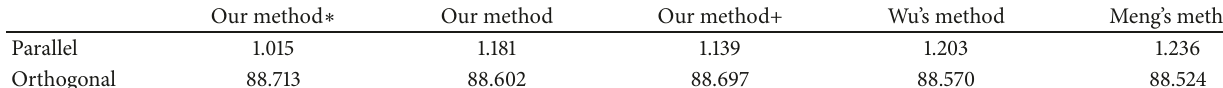
Table 2: The angle of 3D reconstruction results (unit: degree).